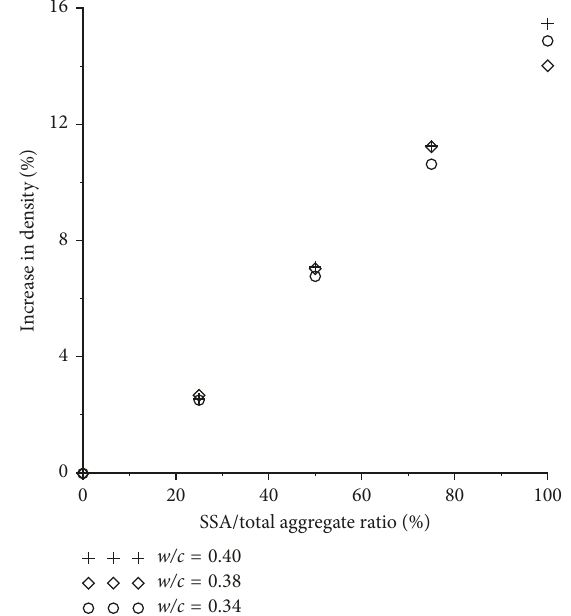
Figure 12: Relationship between the SSA replacement ratio and increase in the air-free density